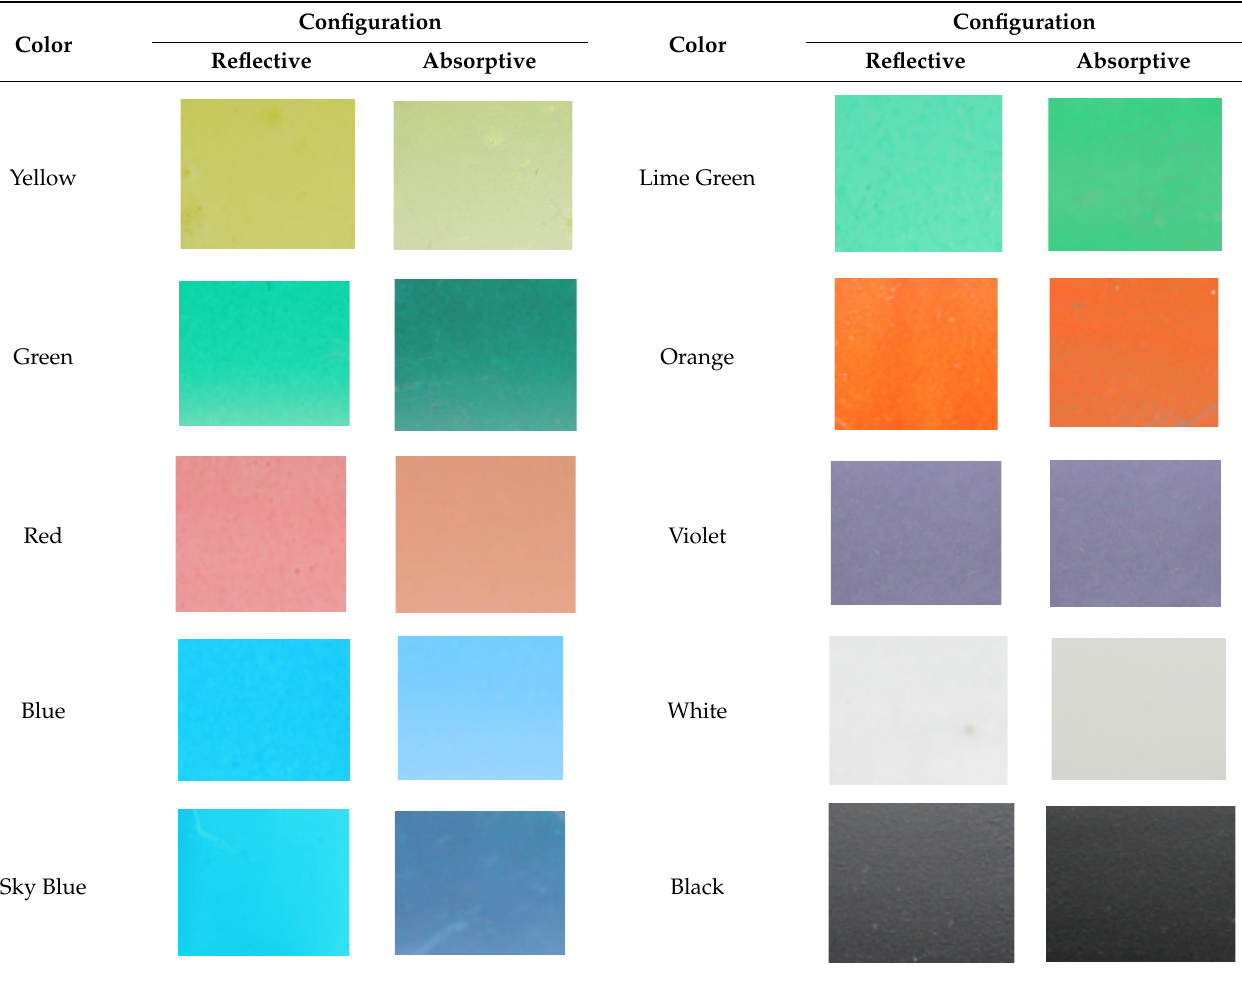
Table 2. Re fl ective and absorptive con fi gurations of bilayers. Pictures taken under calibrated D65 illumination.